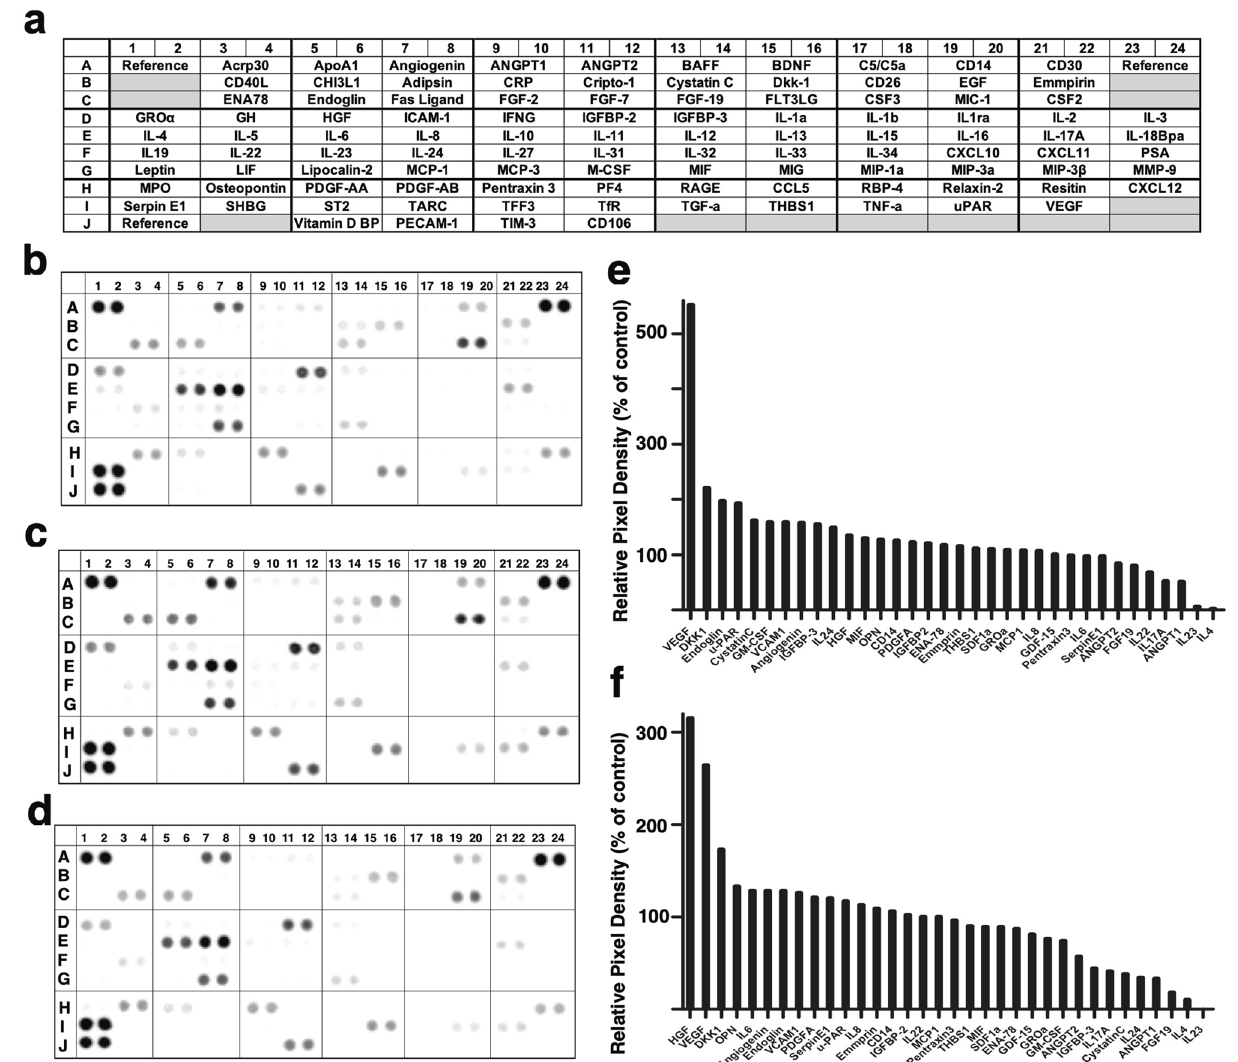
Figure 5. Human cytokine array screening with cultured conditioned media of HAoSMCs after stimulation with SBSN_HUMAN[225–237] or SBSN_HUMAN[243–259]. ( a ) Reference key for cytokine array, adapted from the manufacturer’s information. ( b – d ) Complete array images after probing with conditioned media. HAoSMCs were deprived of serum for 16 h, and incubated without ( b ) or with 10–7 M SBSN_HUMAN[225– 237] ( c ) or 10–7 M SBSN_HUMAN[243–259] ( d ) for 24 h. ( e , f ) Immunoreactivities of respective cytokines released from HAoSMCs stimulated with either SBSN_HUMAN[225–237] ( e ) or SBSN_HUMAN[243–259] ( f ) were quantified and 2-spot mean values relative to untreated experiments are